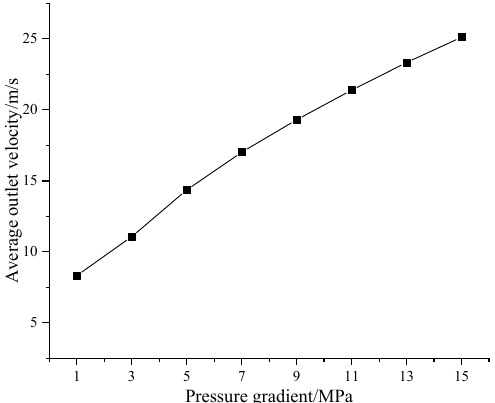
Figure 18. Relationship between entrance pressure and exit flow rate.